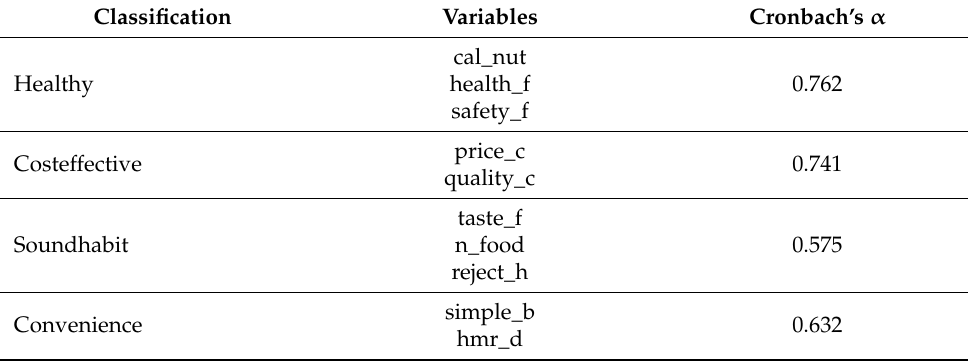
Table 3. Reliability